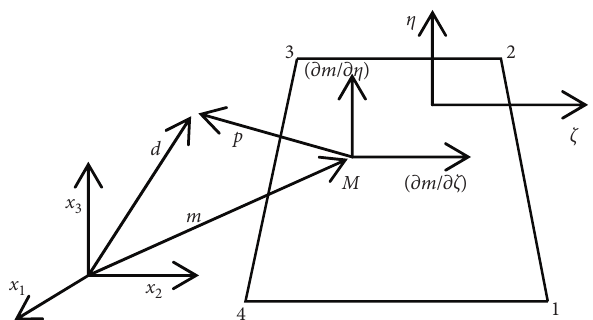
Figure 2: Relationship between the driven node and the active